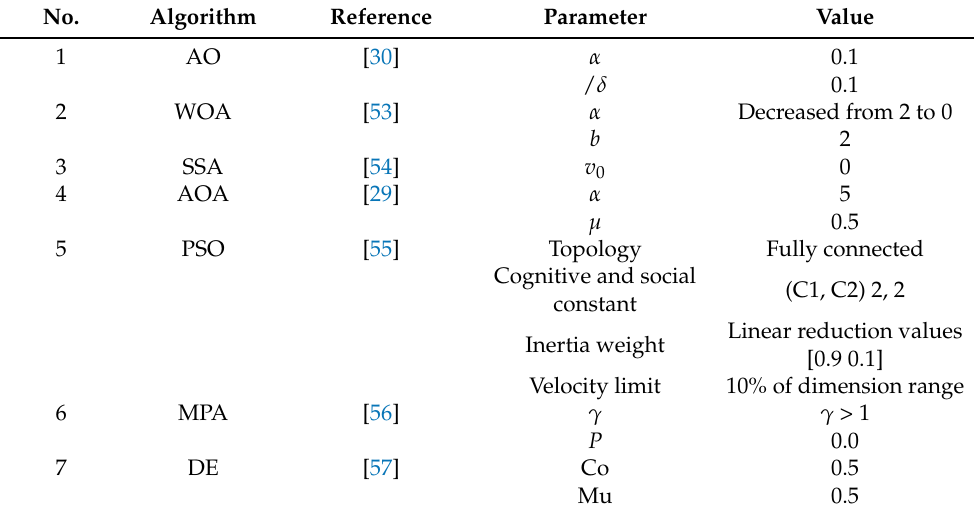
Table 1. Parameter